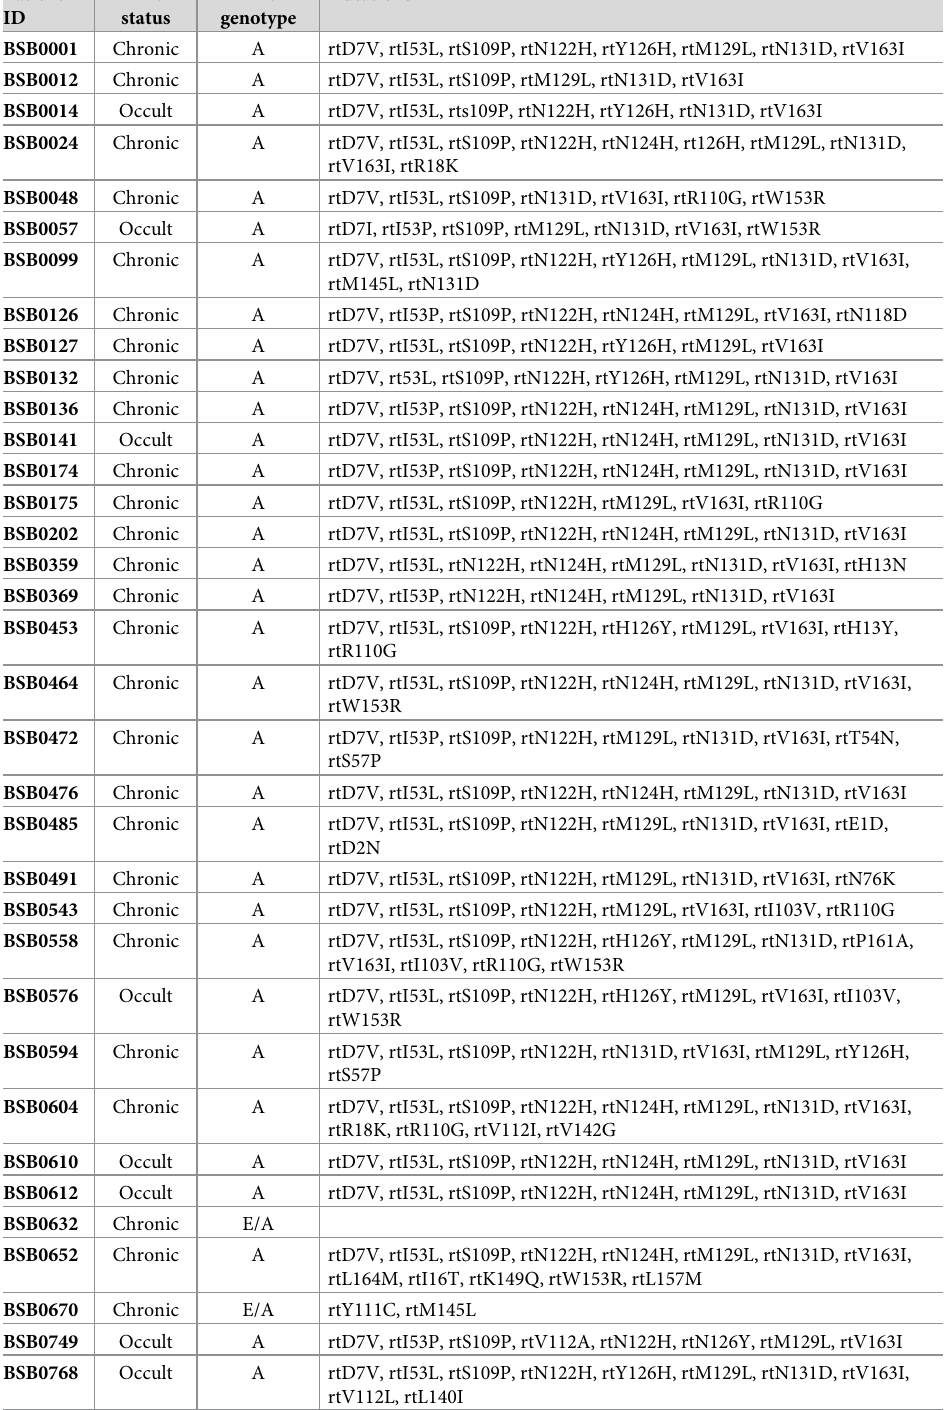
Table 2. Amino acid polymorphisms within the reverse transcriptase (rt) domain of the polymerase open reading frame were observed in all samples except BSB1014 (genotype E/A) and BSB0632 (genotype E/A). The polymor- phism at rtD7 was detected in all genotype A samples. Similarly, polymorphisms at rtI53, rtS109, rtN122, rtN124, rtM129, rtN131D, and rtV163 were frequently identified among genotype A